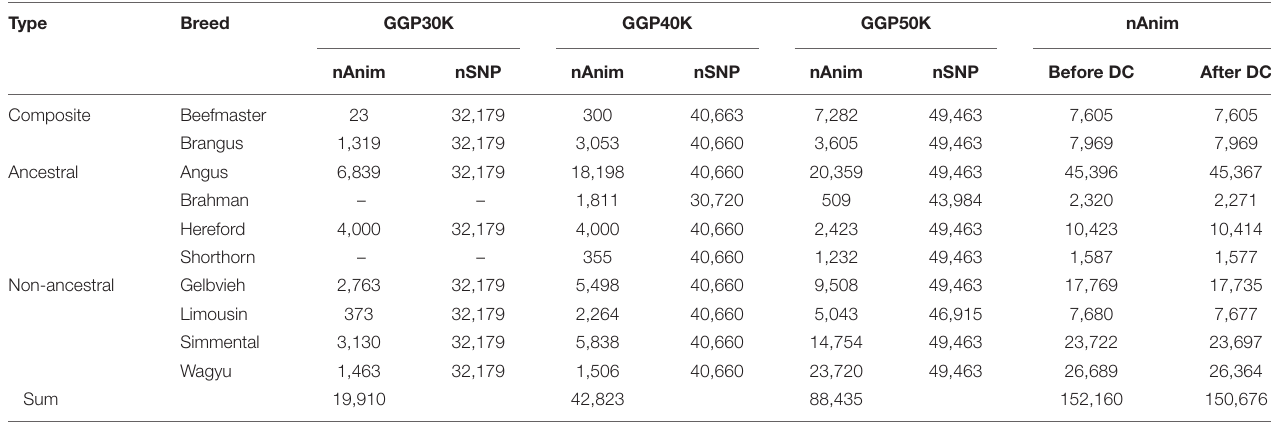
TABLE 1 | Number of genotyped animals and number of SNPs on GeneSeek Genomic Profiler (GGP) 30K (GGP 30K), 40K (GGP 40K), and 50K (GGP 50K) SNP chips used in the present study a , b . Type